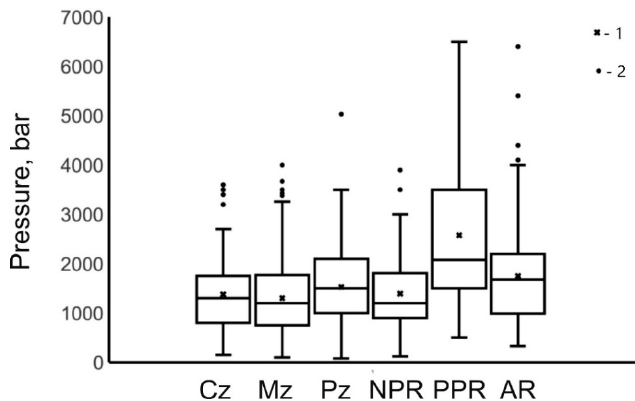
Figure 8. Boxplot diagrams for the pressure of the mineralizing fluids of orogenic gold deposits of various age.